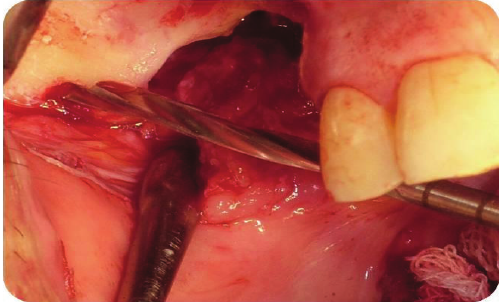
Figure 4: Intraoperative view of zygoma after flap elevation.